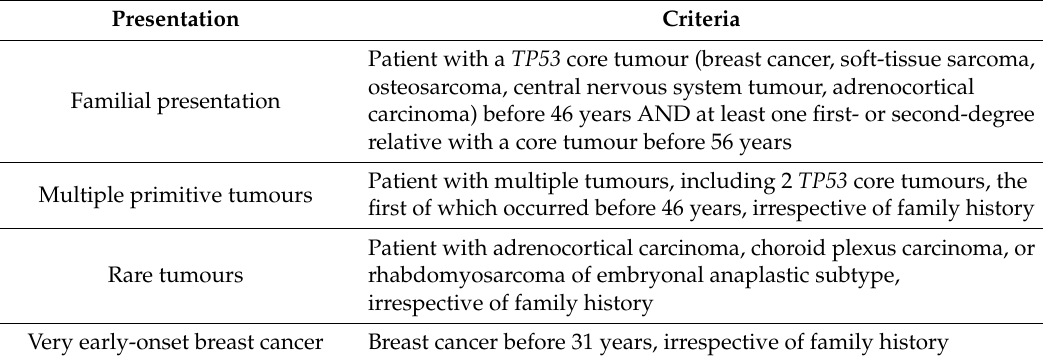
Table 1. Updated Chompret Criteria for Germline TP53 Testing